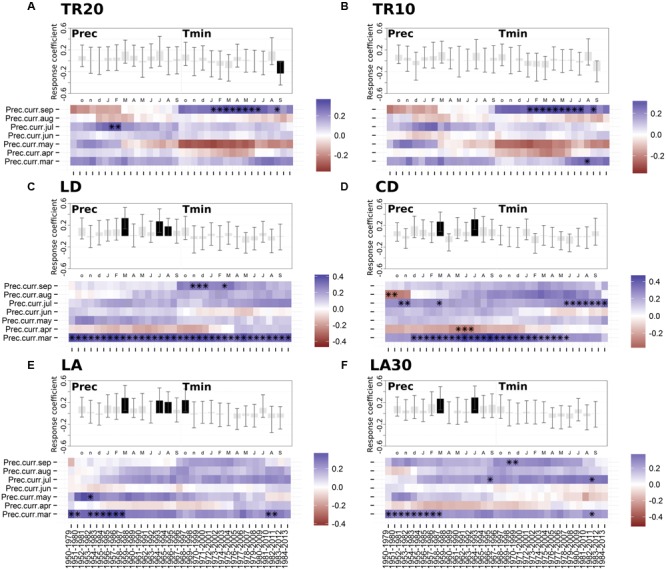
Static (upper graph; significant months are shown in black) and moving (lower graph; significant months are marked by black asterisks) response functions of annual tree-ring chronologies against minimum air temperature and monthly precipitation for the period 1950-2013. (A) Ring-width (20 cores); (B) ring-width (10 cores); (C) lumen radial diameter; (D) cell radial diameter; (E) lumen area (LA); (F) LA of the 30% largest cells. Both temperature and precipitation, from previous October to current September (lowercase letters, previous year months; uppercase letters, current year months), were used in the upper graph (vertical bars indicate 95% confidence interval), while precipitation from March to September and a 30-year moving interval was used in the lower graph. For acronyms see Table 1.